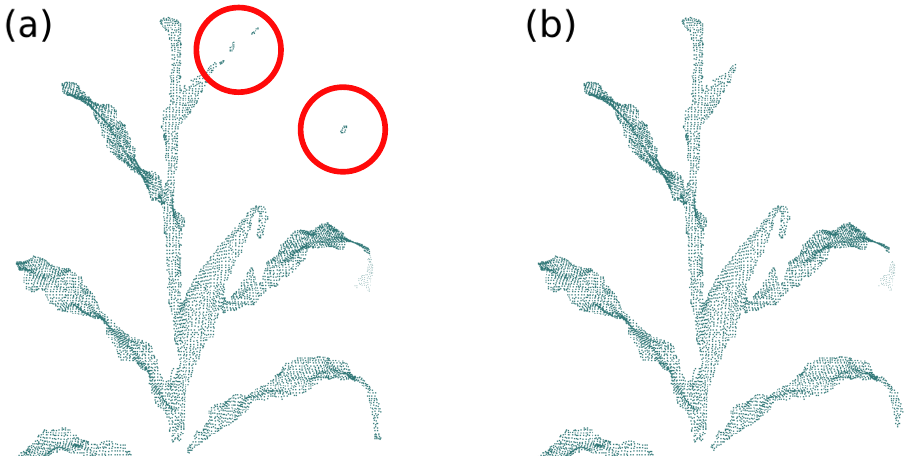
Figure 7. Outliers removal. ( a ) Input point cloud, the red circles indicate regions of outliers and ( b ) point cloud after the outliers removal operation ( f out =